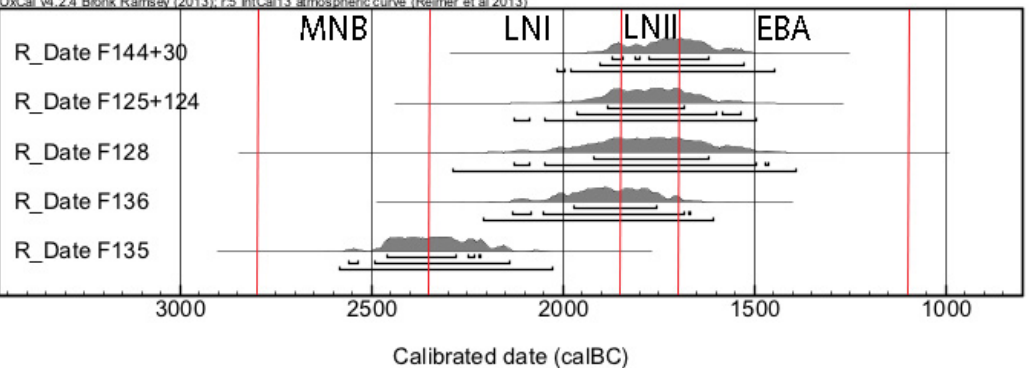
Figure 3. Five previously radiocarbon dates on human bones from Falköpingstad 5. OxCal v.4.2.4 Bronk Ramsey (2013); r:5 IntCal13 atmospheric curve (Reimer et al. 2015). F144+30: St-5157, F125+124: St-5149, F128: St-5150, F136: St-5153, F135: St-5152.The red lines mark different periods: MNB: Middle Neolithic B, LNI: Late Neolithic I, LNII: Late Neolithic II and EBA: Early Bronze